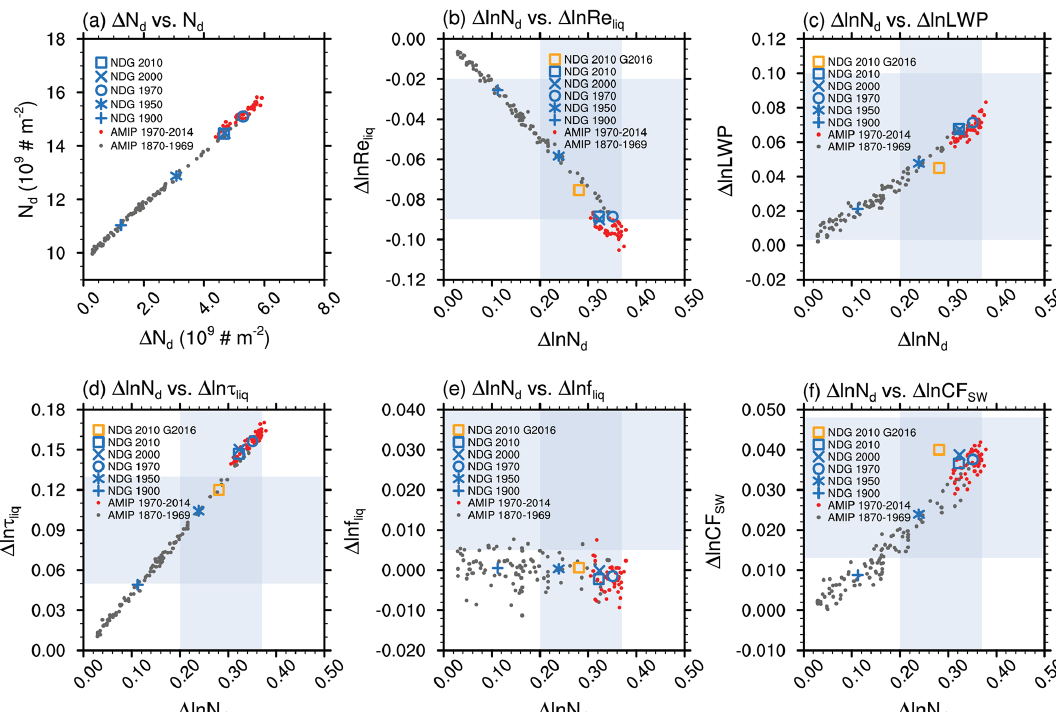
Figure 10. As Fig. 7, but for relationships between (cid:49)N d and N d and between relative changes in N d and other quantities. (cid:49) ln τ liq , (cid:49) ln f liq , and (cid:49) lnCF SW are the relative changes in liquid cloud optical depth, liquid cloud fraction, and shortwave cloud radiative forcing, respectively. (cid:49) ln X = (cid:49)X/X PD . Dark grey dots indicate estimated values from AMIP PD/PI simulations for the years 1870–1969, while red dots are the estimated values for the years 1970–2014. Each dot represents the ensemble-averaged global annual mean field for a certain year. Blue markers show the estimates based on nudged simulations. The orange square shows the nudged simulation results averaged from conditionally sampled high-frequency data following Ghan et al. (2016), wherein CCN (at 0.3% supersaturation) and N d are sampled below 1km and at the top of liquid clouds. The grey area indicates the multi-model estimated range from Ghan et al. (2016). See Sect. 4.3 for